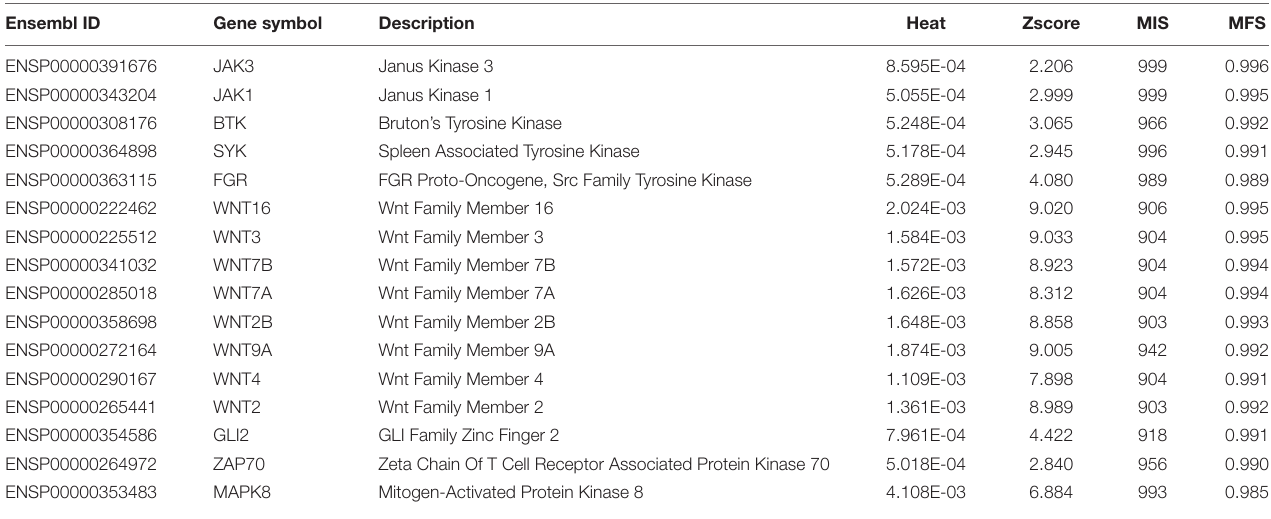
TABLE 1 | Sixteen important inferred uveitis-related